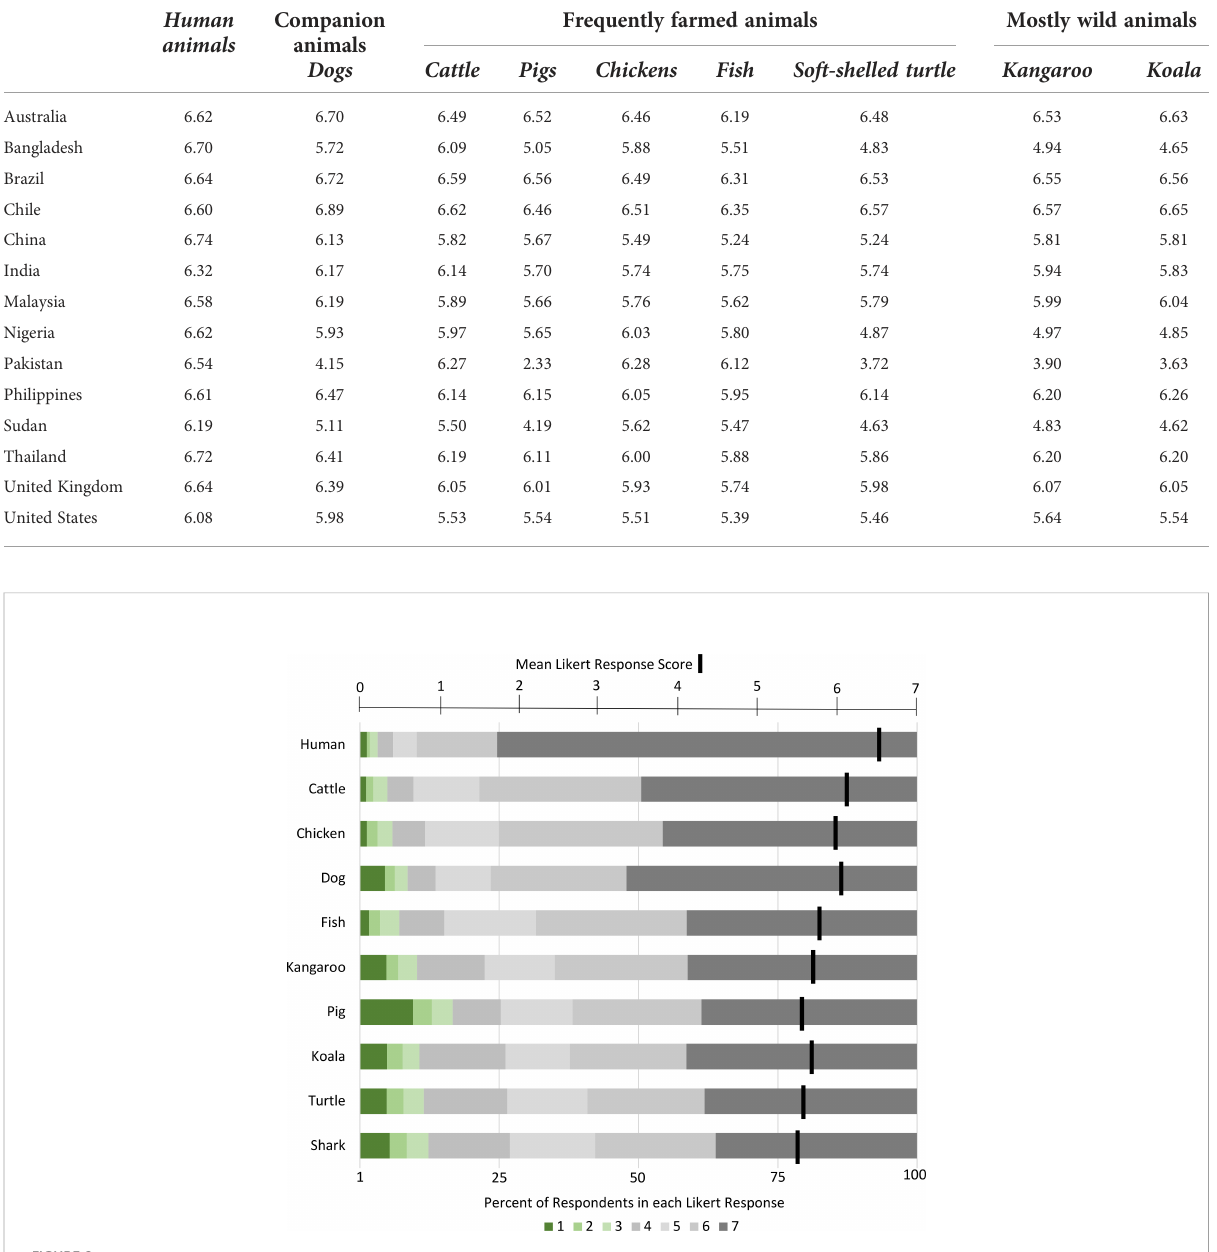
FIGURE 2 Combined International mean Likert score and relative agreement of importance of welfare of each species, colored by Likert response (1 – Strongly Disagree, 2 – Disagree, 3 – Somewhat Disagree, 4 – Neutral, 5 – Somewhat Agree, 6 – Agree, 7 – Strongly Agree) and sorted by percent agreement (total of responses 5 + 6 + 7).